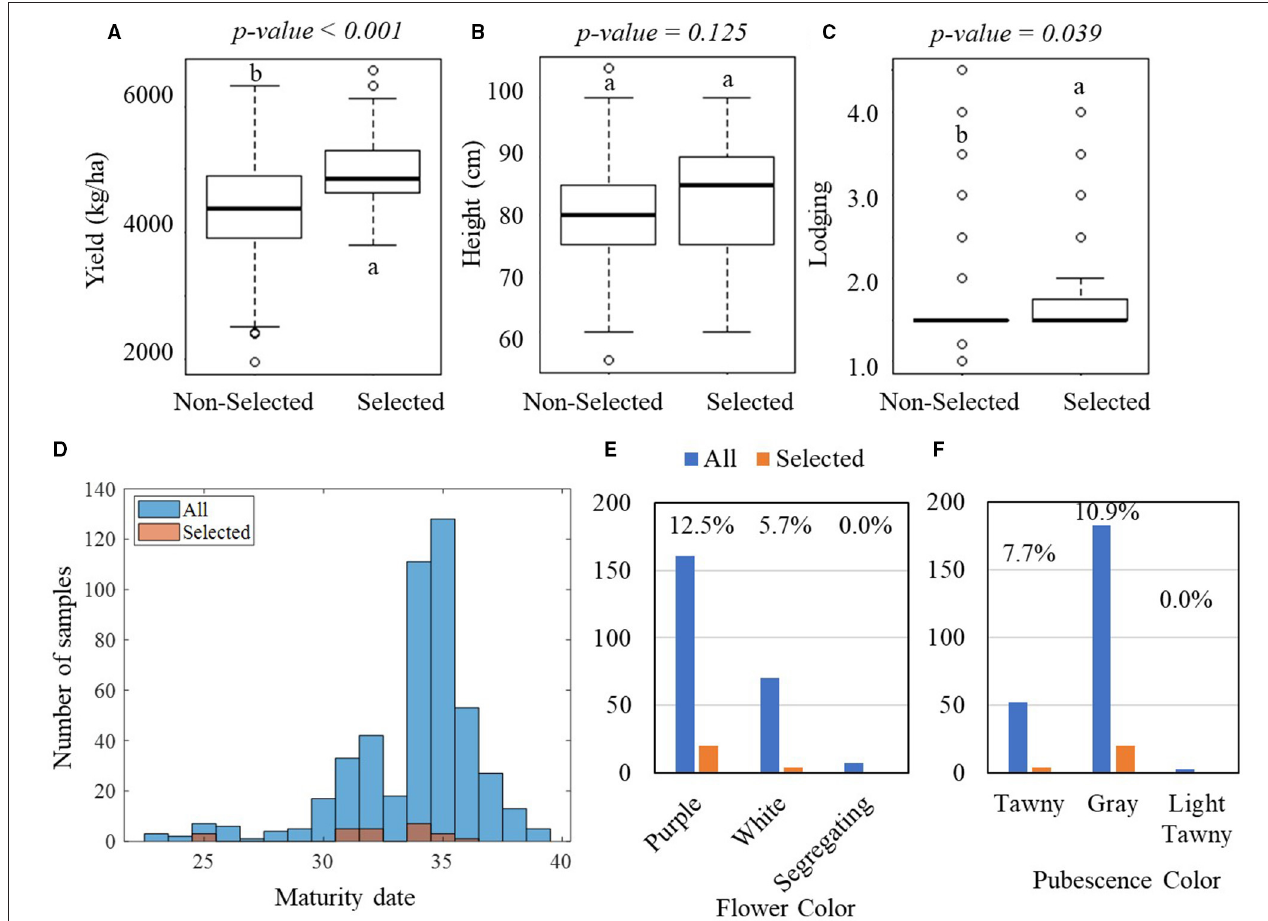
FIGURE 5 | Comparisons of manually measured agronomic traits between the selected and non-selected groups in the AYT. In the AYT, 44 breeding lines were selected, while 194 breeding lines were non-selected. (A–C) Boxplots of the comparisons in yield, plant height, and lodging, respectively. The lower-case letters above bars indicate the significant difference among these means at the above significance levels ( p-values ). (D) Histogram of the maturity dates. (E,F) Bar plots of the flower and pubescence colors. For (E,F) , the blue bars represent all breeding lines, while the orange bars represent the selected breeding